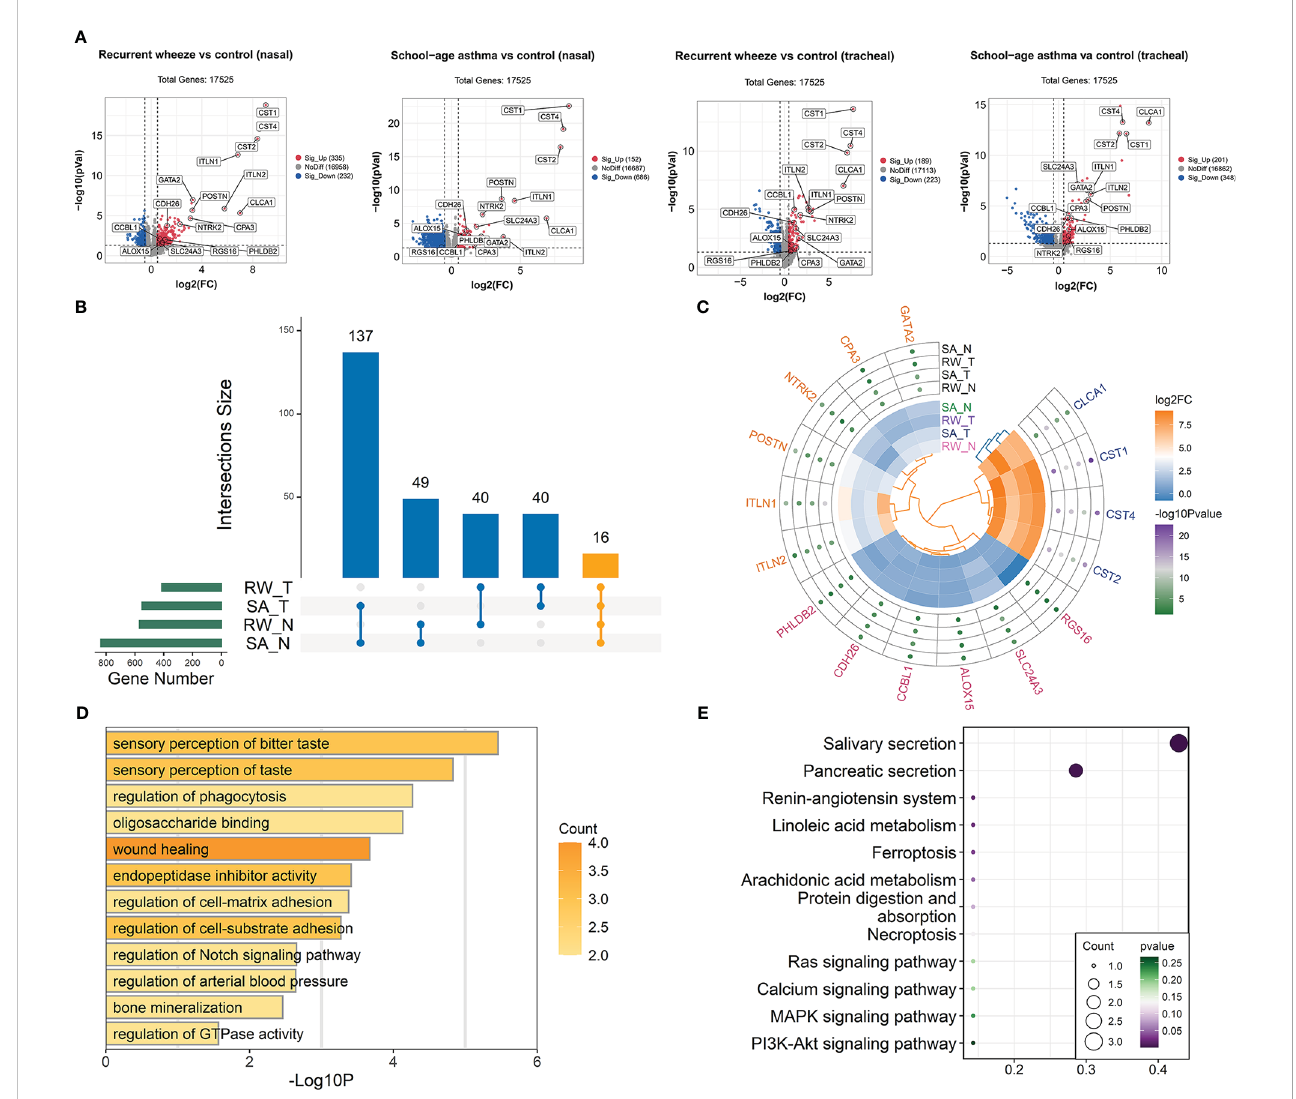
FIGURE 4 Identi fi cation of co-DEGs shared by RW and SA across upper and lower airways. (A) Volcano plots showing DEGs between healthy controls and children with RW/SA. (B) UpSet diagram showing overlapping DEGs between RW and SA across nasal and tracheal samples. In total, 16 co-DEGs were shared by RW and SA across nasal and tracheal samples. (C) Heatmap visualization of differential expression changes (colors in inner circle indicates corresponding log2FC) and signi fi cance values (colors in outer circle represent corresponding -log10 P -value) for 16 co-DEGs derived from integrated analysis. (D) GO term enrichment analysis of co-DEGs. (E) KEGG pathway enrichment analysis of co-DEGs. co-DEGs, common DEGs; DEGs, differentially expressed genes; FC, fold-change; GO, Gene Ontology; KEGG, Kyoto Encyclopedia of Genes and Genomes; N, nasal; RW, recurrent wheezing; SA, school-age asthma; T,